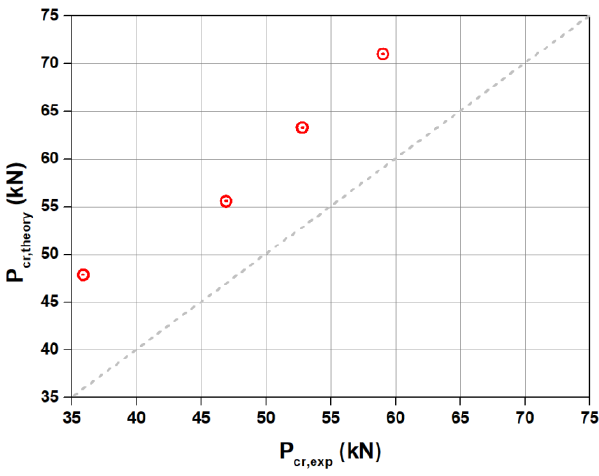
Figure 12. Comparison of 𝑃 𝑐𝑟,𝑒𝑥𝑝 and 𝑃 𝑐𝑟,𝑡ℎ𝑒𝑜𝑟𝑦 .